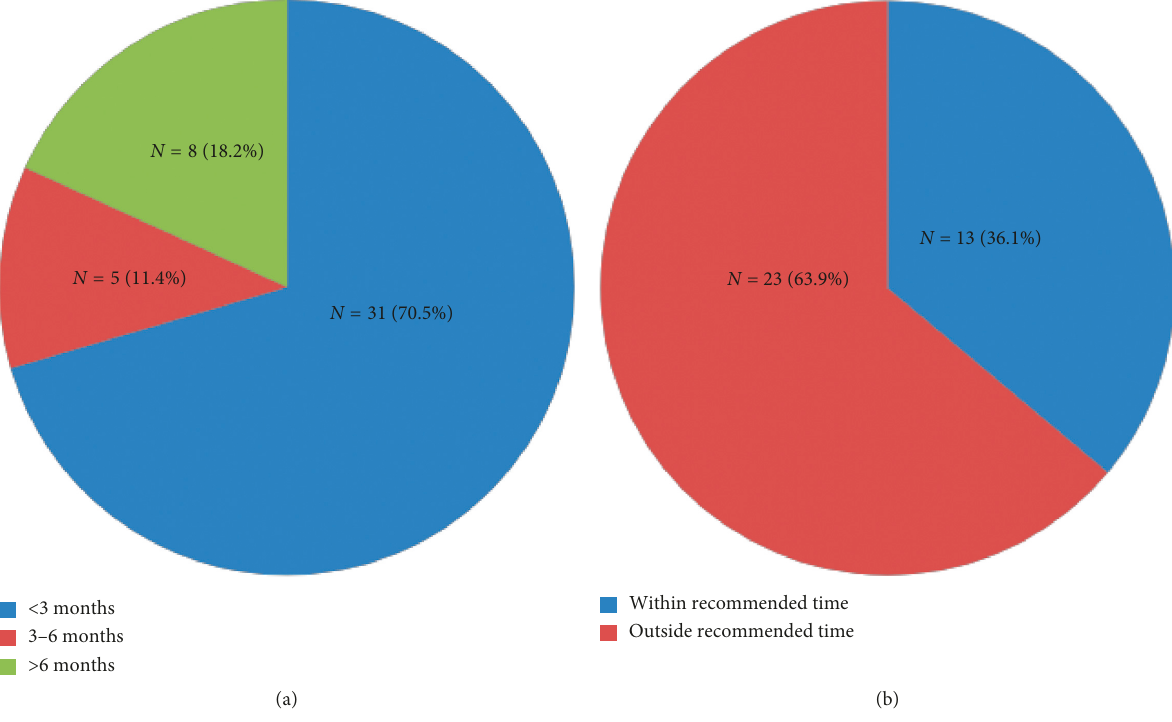
Figure 3: Time to receiving interventional, surgical, and radiological follow-up. In the combined surgical and interventional group, a majority (70.5%) of the patients underwent surgical resection or biopsy or transbronchial biopsy or cytology within 3 months (a). In the radiological follow-up group, 36.1% of the patients had a follow-up CT chest within the interpreting radiologist’s recommended time interval